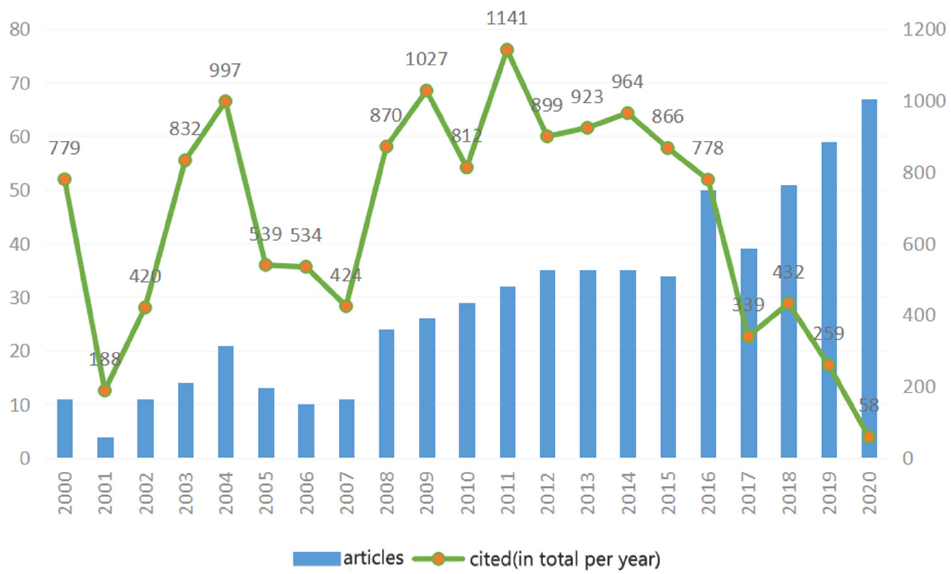
Figure 1. Number of articles by year of publication and number of citations received in subsequent years.